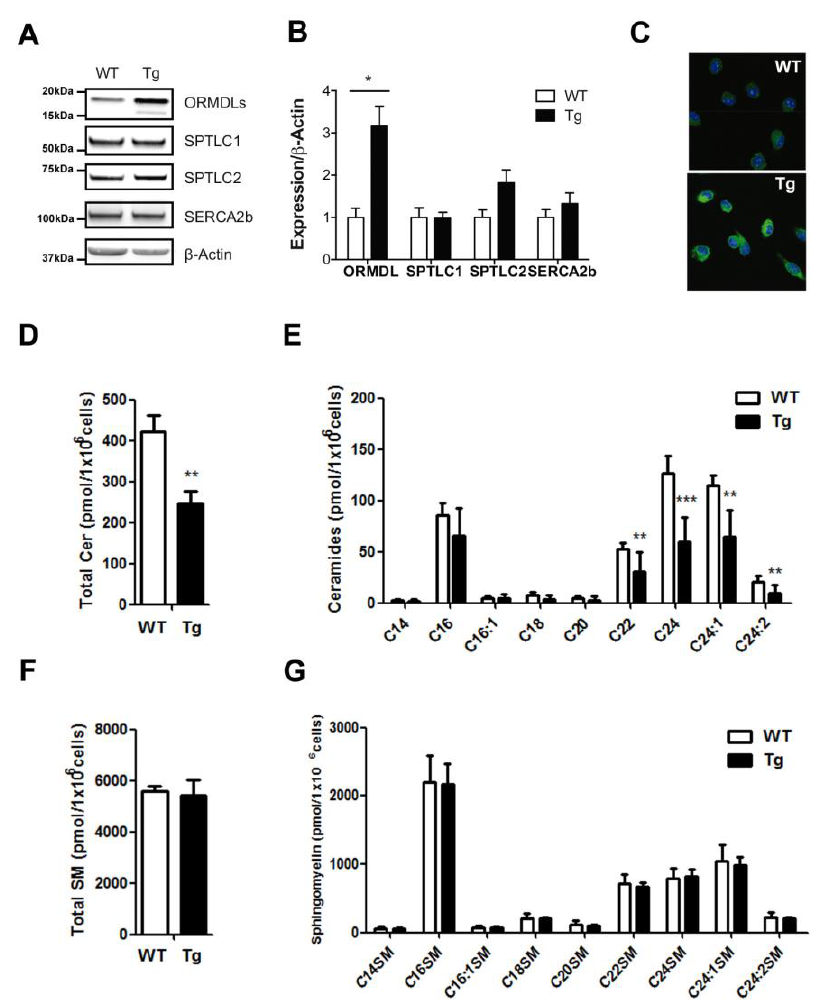
Figure 1. Ceramide content of macrophages in hORMDL3 Rosa26 mice. ( A , B ) Western blot in wild type (WT) and transgenic (Tg) mice of SERCA2b, SPTLC1, SPTLC2, ORMDLs, and actin, using 50 µg of protein from bone-marrow-defined-macrophages (BMDM). ( A ) Representative Western blot; ( B ) graph with quantification analysis normalized to actin. Statistics: n = 4; Mann-Whitney test; * p < 0.05; ( C ) immunostaining using anti-ORMDL antibody (green) and TO-PRO-3 (blue) of BMDM from WT and Tg mice; ( D , E ) Ceramide content in BMDM macrophages from WT and hORMDL3 Rosa26 (Tg) mice, quantified by mass spectrometry. ( D ) Graph with total ceramide content. ( E ) Contribution of the different ceramide species. ( F ) Graph with total sphingomyelin content. ( G ) Contribution of the different sphingomyelin species. Statistics (D–F): WT n = 13, Tg n = 11; Mann-Whitney test; * p < 0.05; ** p < 0.01; *** p < 0.01. Error bars represent standard error.